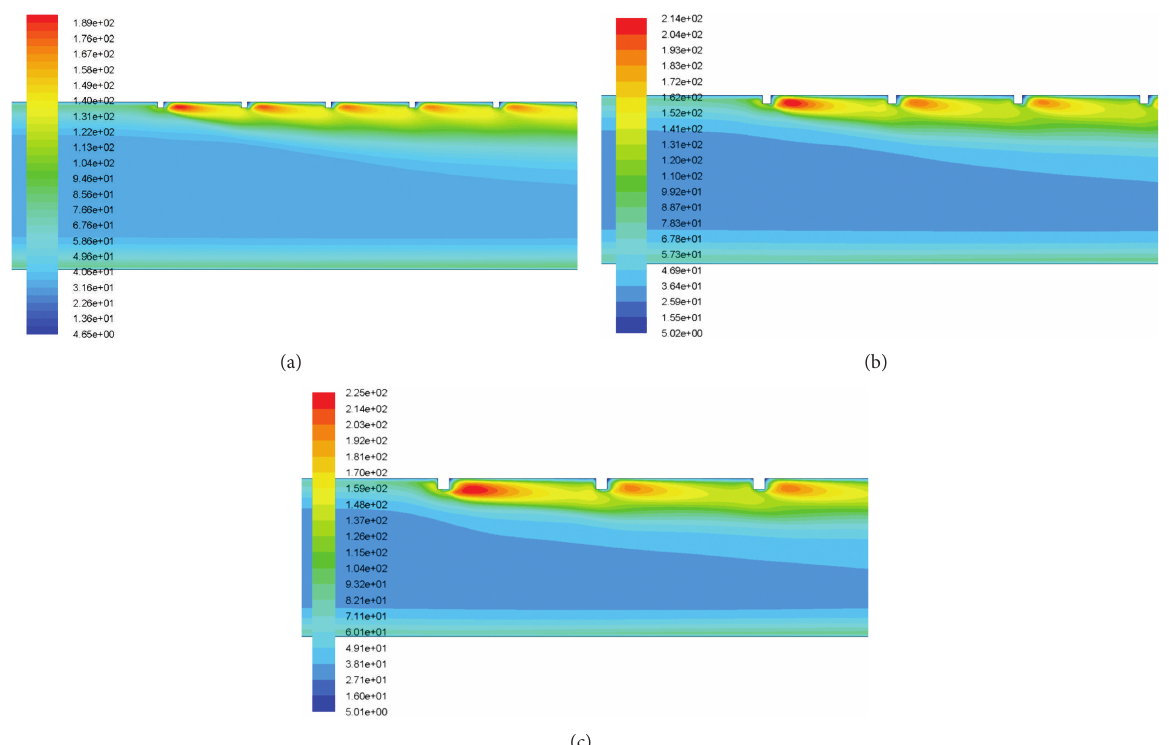
Figure 7: The contour plot of turbulent intensity for Re = 18,000 and 𝑃/𝑒 = 14.29 at a relative roughness height of (a) 𝑒/𝐷 = 0.03 , (b) 𝑒/𝐷 = 0.42 , and (c) 𝑒/𝐷 = 0.06 .